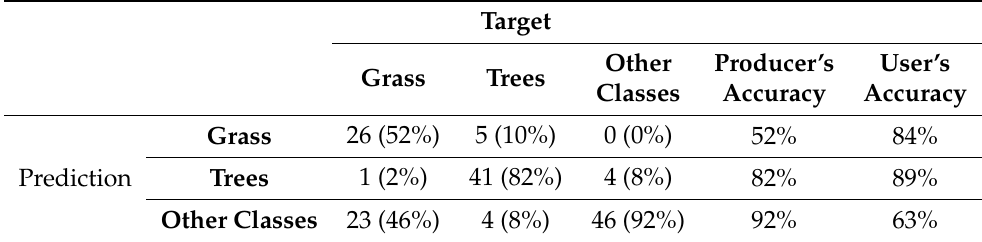
Table 1. Confusion Matrix for measuring Vegetation Cover (Trees) and Grass Infestation (Grass) accuracy.